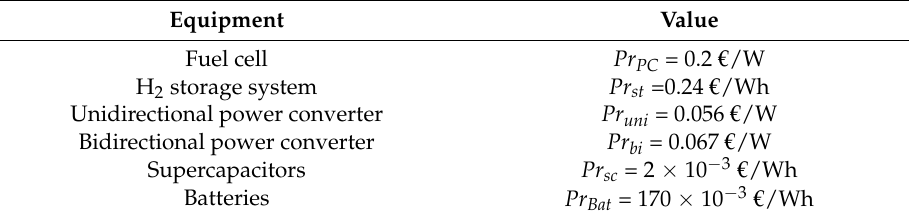
Table 2. Subsystems architectures price for production of 500,000 units